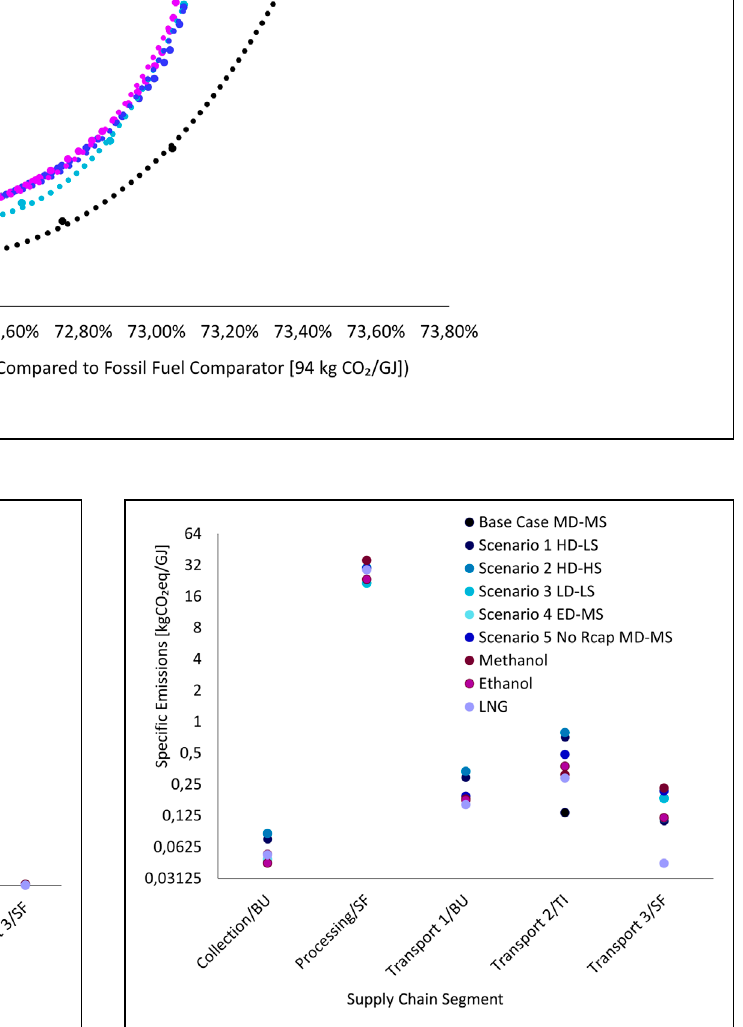
FIGURE 6 | Specific energy costs per supply chain segment.